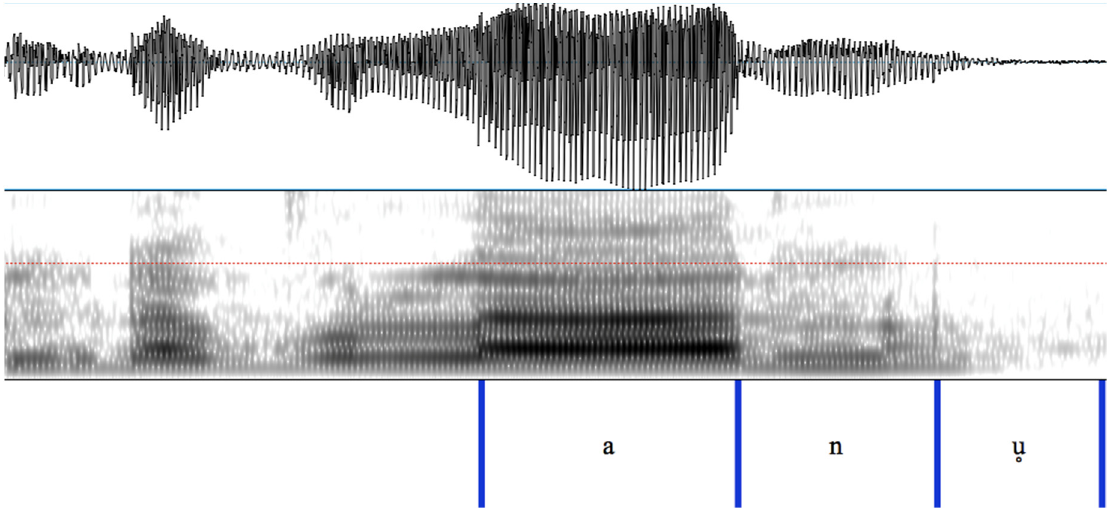
Figure 4. Example of devoicing by younger speaker TE (a-nu ‘go- PST ’) (SW20190412-07-BKCow).